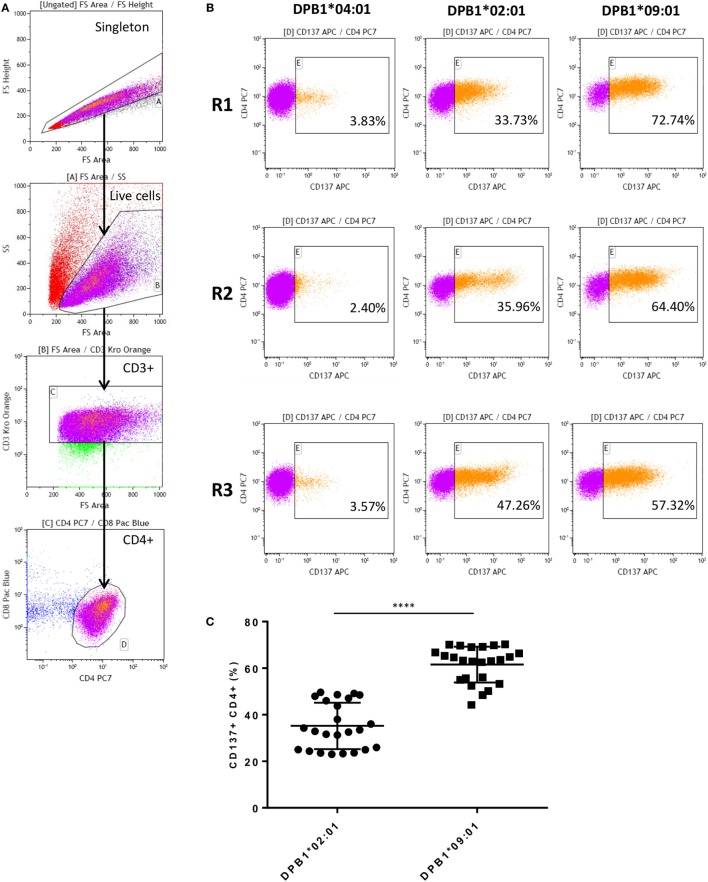
Alloresponses from self-DPB1*04:01,*04:02 individuals against HLA-DPB1*02:01 and DPB1*09:01 result in stronger responses against the latter. Isolated untouched CD4+ T cells from the three self-DPB1*04:01/*04:02 responders (R) were cocultured with HeLa cells expressing DPB1*02:01 or DPB1*09:01. After 2 weeks, expanded alloreactive T cells were restimulated for 24 h against HeLa cells expressing the original DPB1 alloantigen or an autologous allele, and the degree of T cell response was quantified as the proportion of CD4+CD137+ cells. (A) Gating strategy: cells are gated on the live cells and CD3+CD4+ cells. (B) Representative responses from each of the subjects. Left panels, background response of alloreactive cells against the autologous allele DPB1*04:01; middle panels, response against allogeneic DPB1*02:01; and right panels, response against allogeneic DPB1*09:01. (C) The specific response against each allele was quantified in parallel repeats (n = 8) for each subject after deduction of the background levels of CD137 positivity against HeLa expressing the autologous allele (average 4.11%). Mean response (and SD) against DPB1*02:01 and DPB1*09:01 was 35.2% (9.95) and 61.54% (7.69), respectively (p < 0.0001).